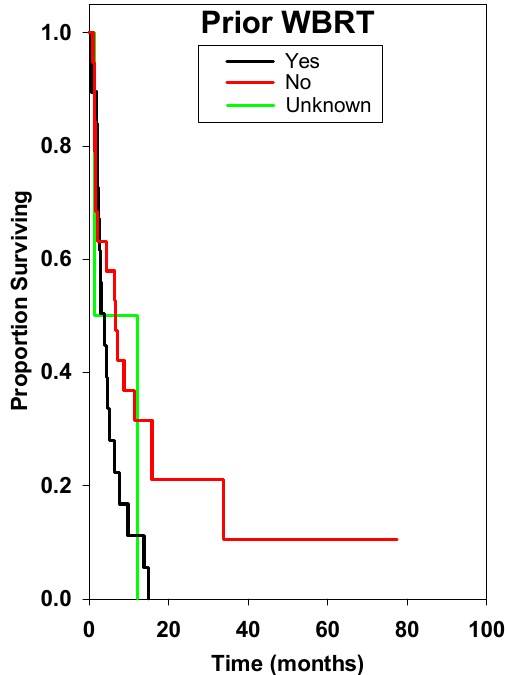
Figure 4. Survival curve comparing patients with whole brain radiation therapy (WBRT). There was a statistically significant reduced survival in patients with prior or concurrent WBRT in the multivariate analysis ( p = 0.019). This finding was likely due to increased overall brain tumor load.